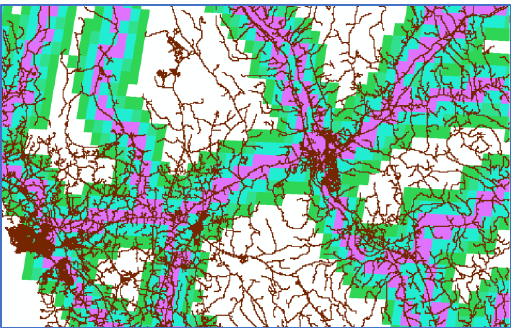
Figure 9. The i nput of index values of the HFI index, exemplified with the layer “roads” shown in intensity classes from purple (highest) to green (lowest) with a resolution of 1 km, overlayed by the road map input of the LUI with resolution 100 m. Note that the HFI index inputs are filtered and do not include small roads.